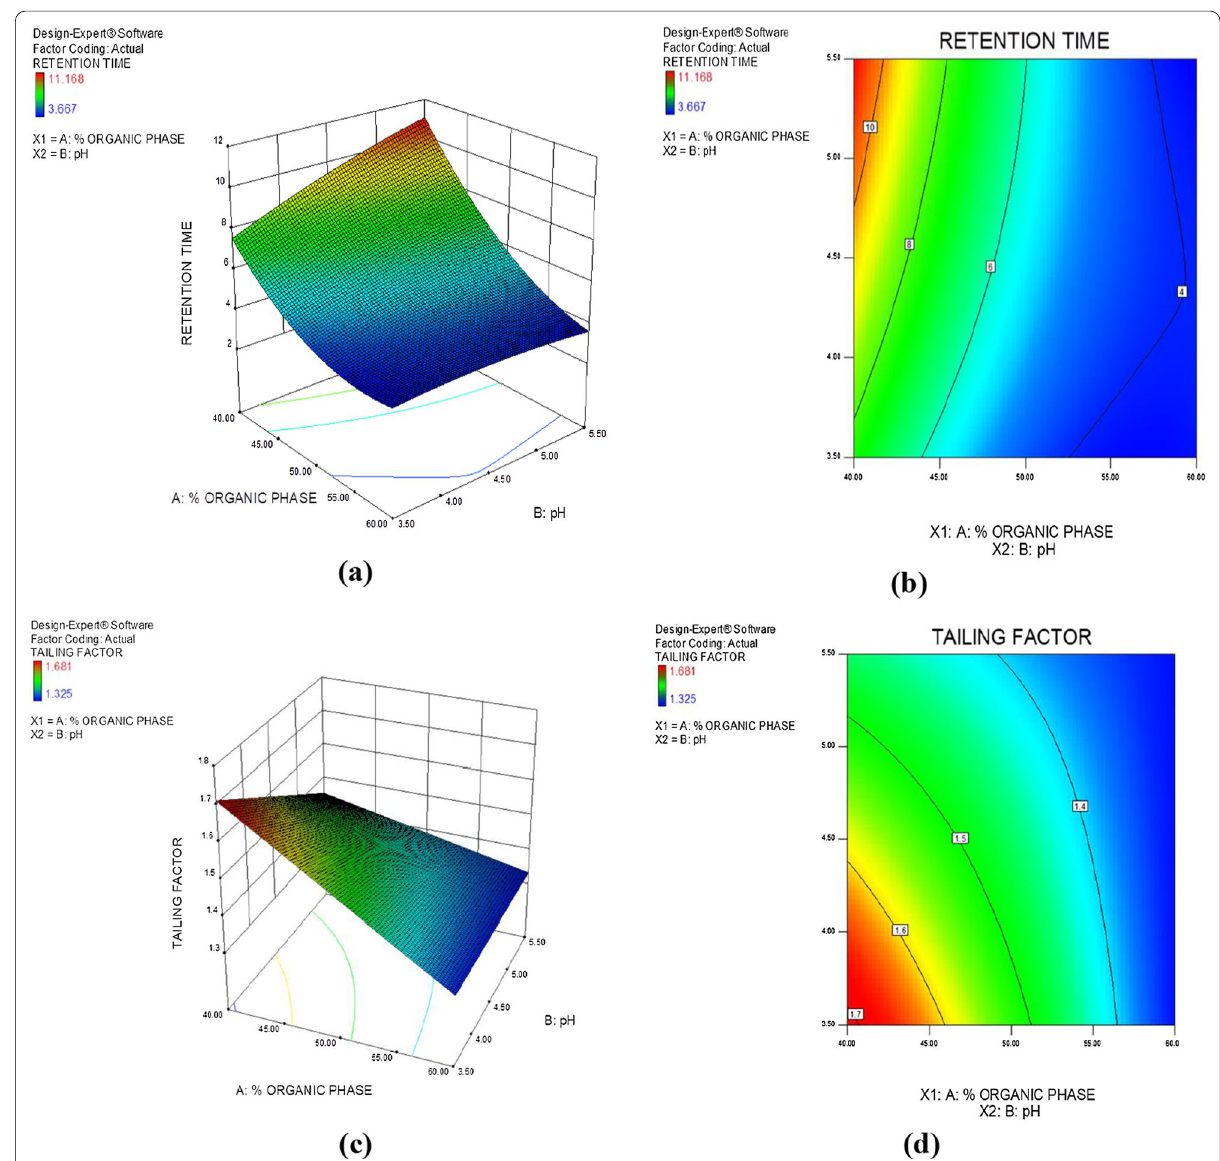
Fig. 1 a , b represent the 3D response curve and 2D contour plots for response 1, i.e., retention time; c , d represent the 3D response curve and 2D contour plots for response 2, i.e., tailing